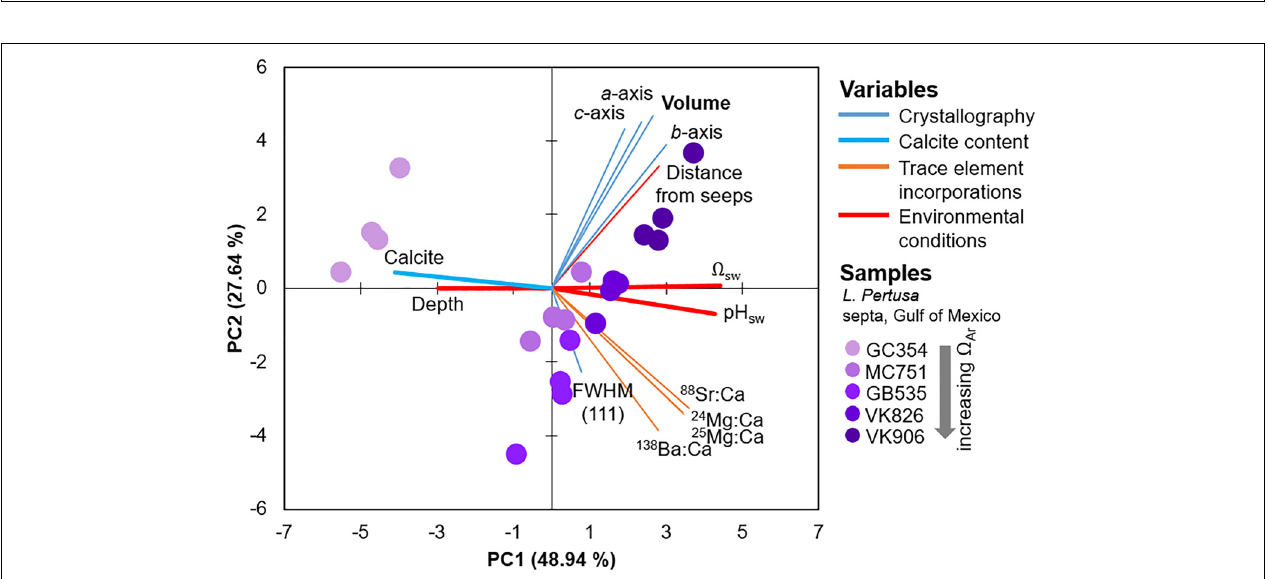
FIGURE 3 | Principal component analysis (PCA) biplot of component 1 versus 2 which accounts for 75% of the variability between samples of L. pertusa septa from the Gulf of Mexico (purple circles). All of the variables measured in this study are expressed as vectors in solid lines.